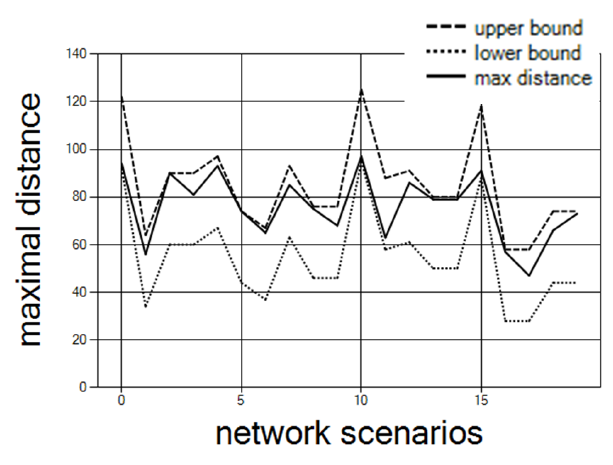
Figure 11. Maximal distance between lower and upper bounds.